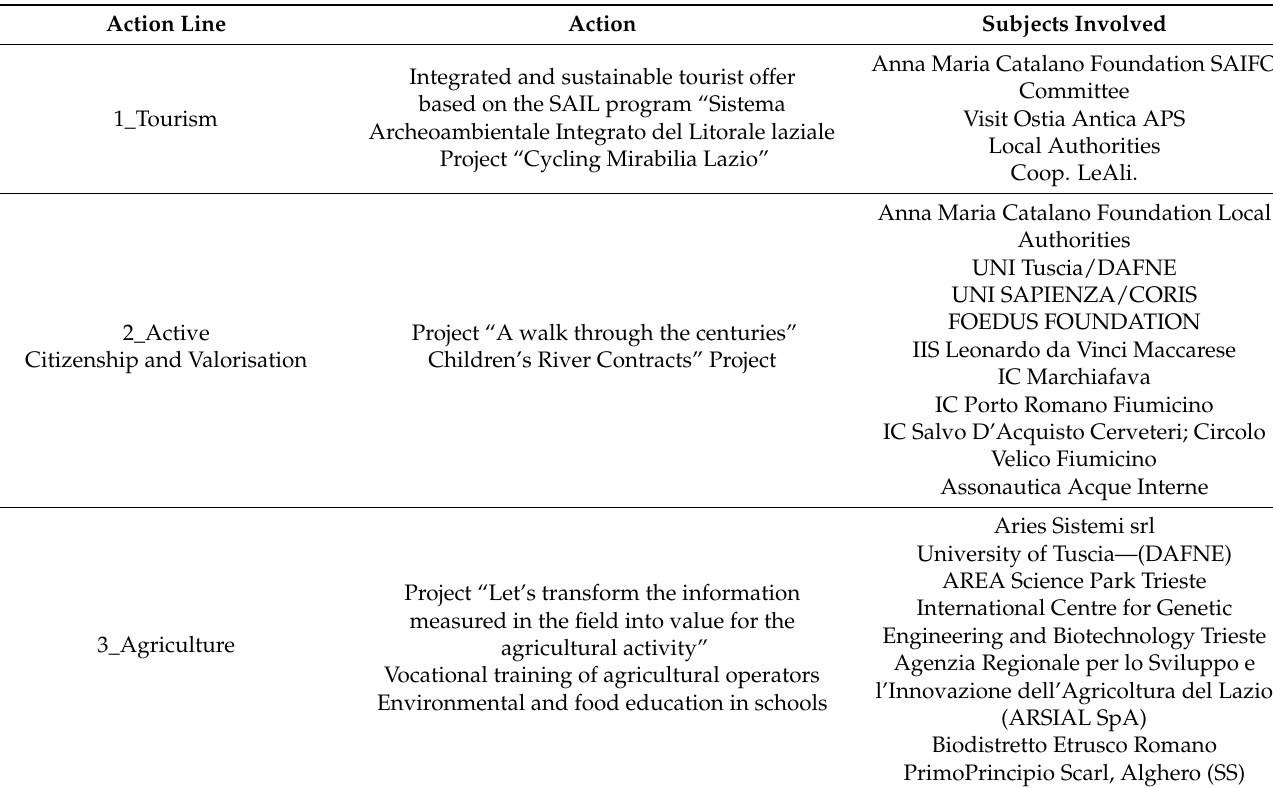
Table 5. The construction of the Action Program (Phase 4) of the River, Coastal, and Landscape Contract Arrone. Source: authors’ elaboration (2022) from data of the official web site of the con- tract available at https://contrattodifiumearrone.it/documentazione-progettuale/ (accessed on 20 July